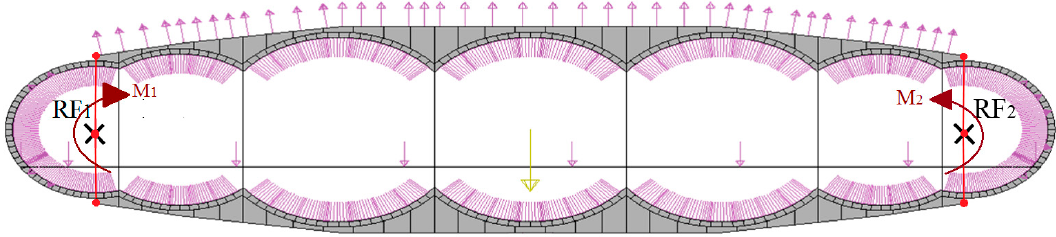
Figure 3b. The outer skin contributes to the stiffness with respect to the bending moment exerted by the wing forces and experiences according stress. Buckling instability in the outer- and cabin-skin is prevented by stiffening the thin skin with frames, stringers, chord- and